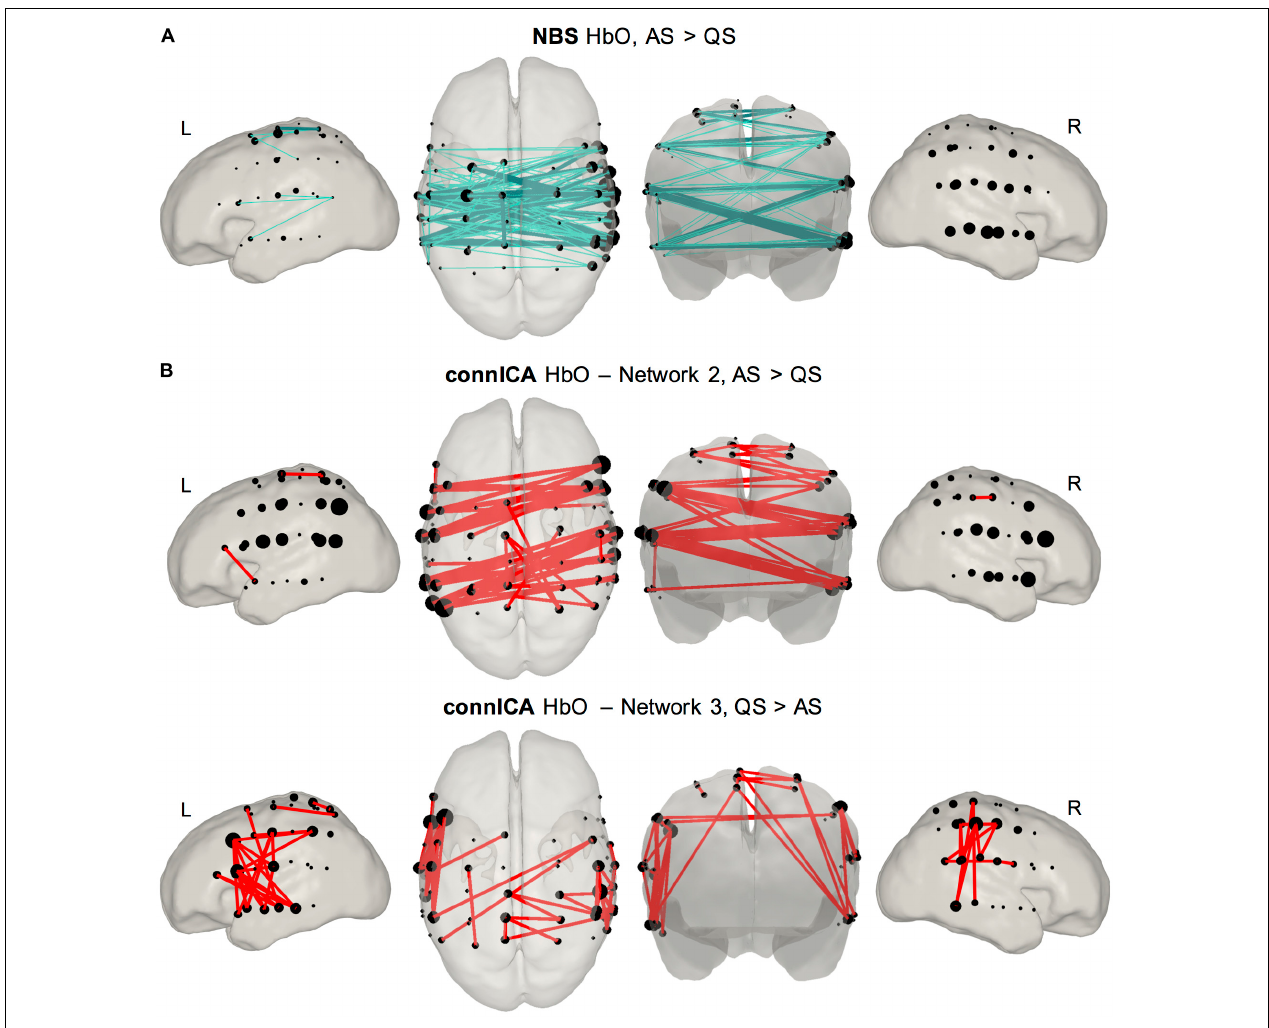
FIGURE 5 | Results of connectome based analyses revealing group differences between sleep states. (A) NBS method (top row) showed a network mainly characterized by interhemispheric connectivity which was stronger in AS compared to QS. Results are presented for two statistical thresholds ( t 1 , p < 0.001 empirical permutation test, light color, thin edges; t 2 , p < 0.005 empirical permutation test, dark color, thick edges). This difference was only observed for HbO. (B) ConnICA method (second and third rows) revealed two networks showing significant differences between sleep states. Network 2 represents a functional connectivity pattern formed by interhemispheric edges showing a higher prominence during AS [ t (19) = 3.19; p = 0.0048]. Network 3 is a RSN characterized by short-range unilateral edges displaying stronger connectivity during QS [ t (19) = –3.09; p = 0.006]. These network level differences were observed for both HbO and HbR. Due to the high spatial similarity between the observed HbO and HbR networks only figures for HbO are presented in the main text, and HbR figures are presented as Supplementary Material